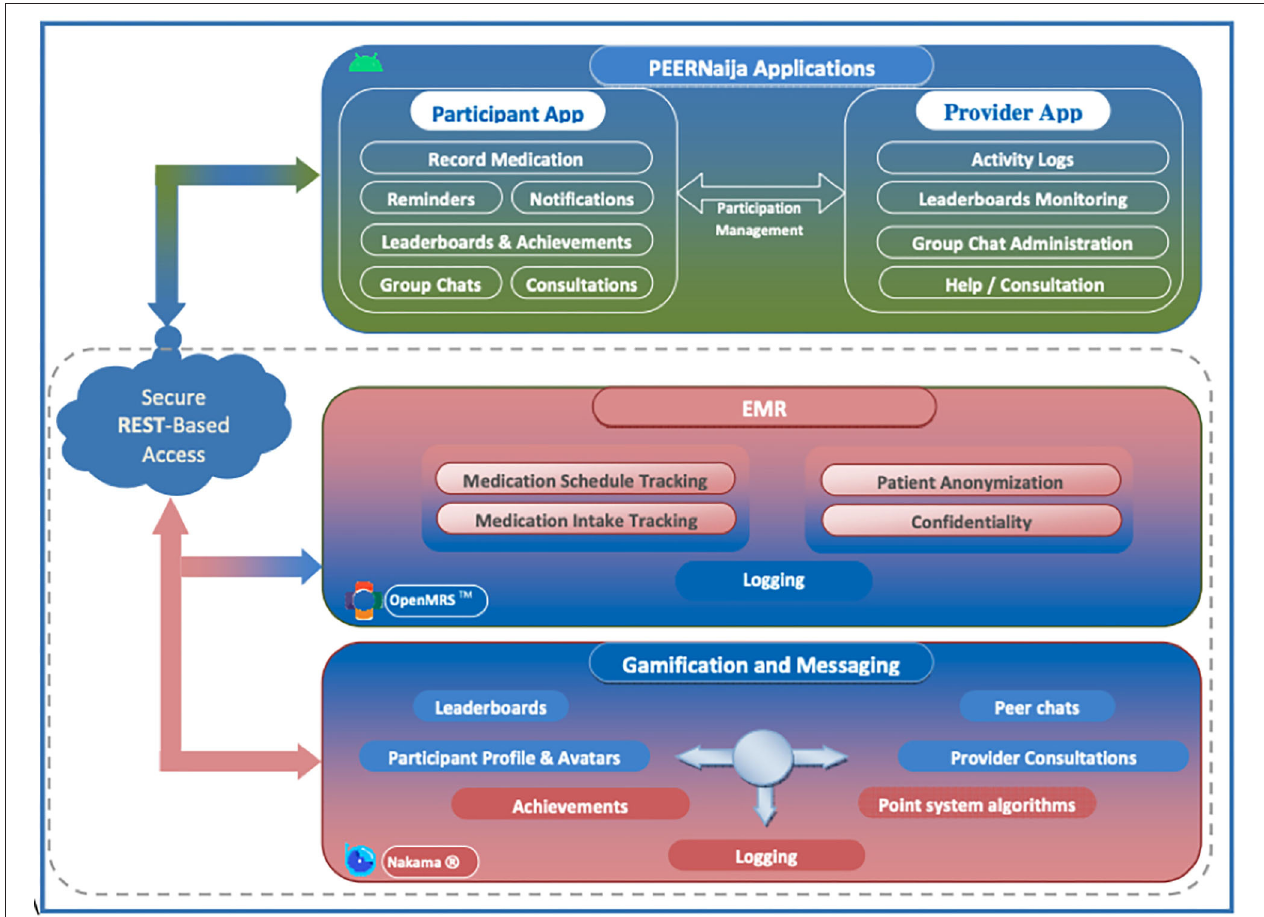
FIGURE 2 | PEERNaija